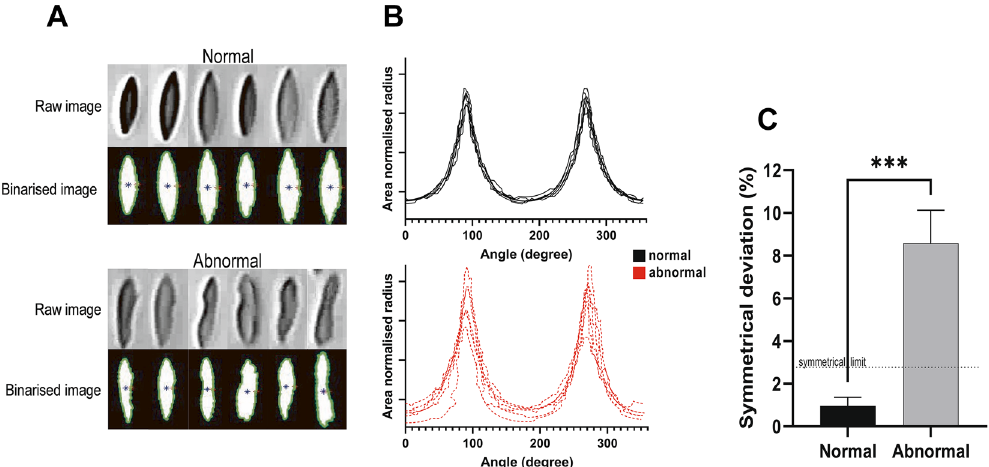
Figure 4. Asymmetry analysis for red blood cells (RBC) identified to have normal and abnormal morphology in shear flow. Following identification of a cell, each cell was binarised, edges detected, and centroid identified ( A ). The radius from the centroid to the cell’s edge was measured around the circumference ( B ). Comparative symmetrical variation significantly differed between normal and abnormal RBC ( C ). The symmetrical upper limit at 2.77% represents ¯ x + 2 σ for normal symmetrical deviation. *** p < 0.001.